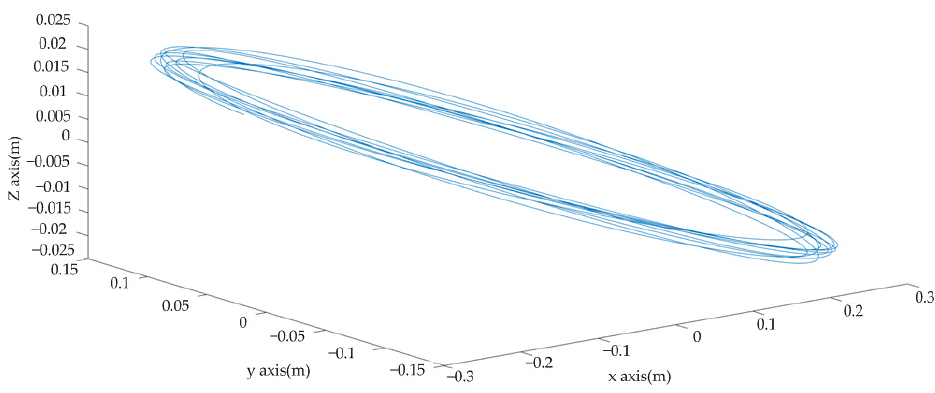
Figure 17. Wire galloping space trajectory diagram.